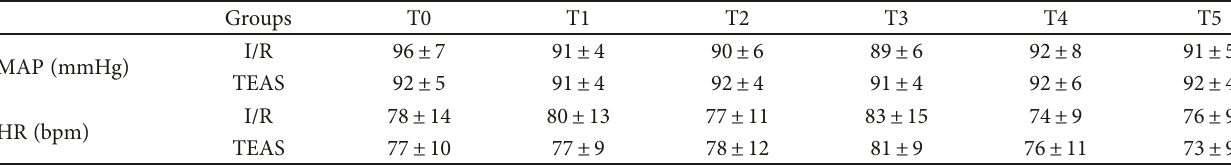
Table 2: Mean arterial pressure and heart rate of the two groups ( n = 20 in each group). Data are expressed as mean ± standard deviation.